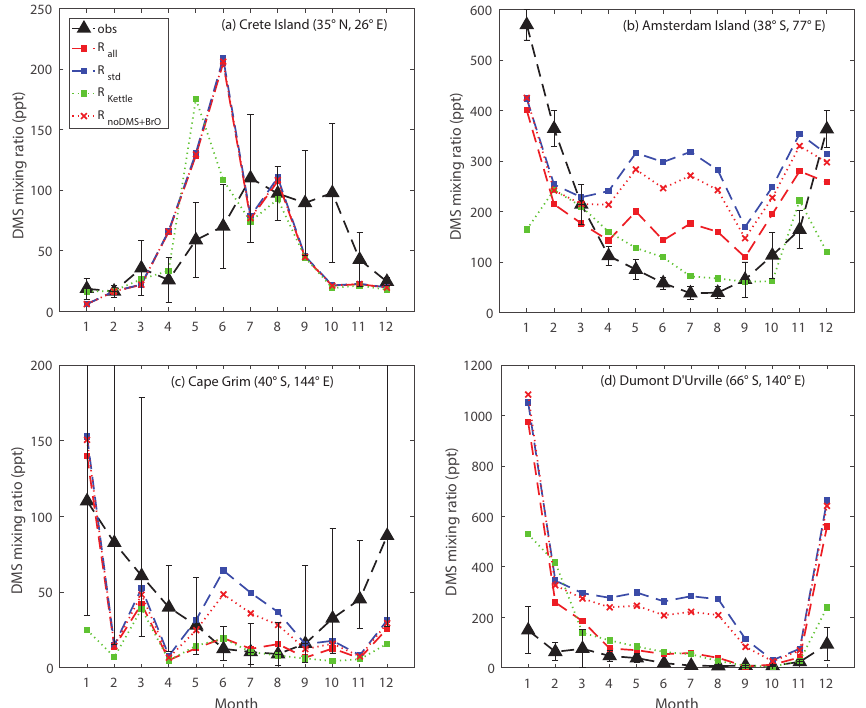
Figure 9. Comparison between modeled and observed monthly mean surface DMS mixing ratios at (a) Crete Island (CI), (b) Amsterdam Island (AI), (c) Cape Grim (CG), and (d) Dumont D’Urville (DU)